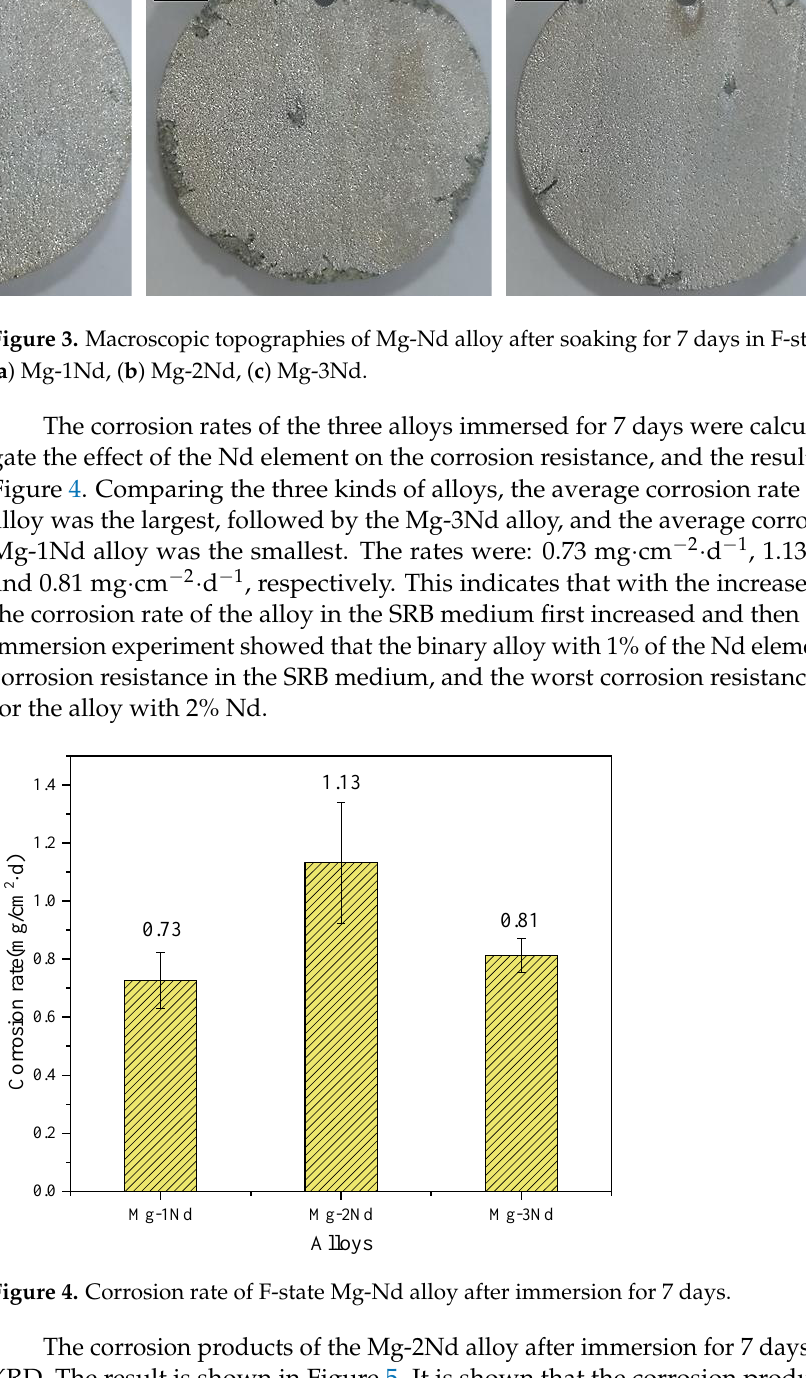
Figure 4. Corrosion rate of F-state Mg-Nd alloy after immersion for 7 days. The corrosion products of the Mg-2Nd alloy after immersion for 7 days were tested by XRD. The result is shown in Figure 5. It is shown that the corrosion products covered on the surface were Mg(OH) 2 . This comes from the corrosion reaction of the α -Mg